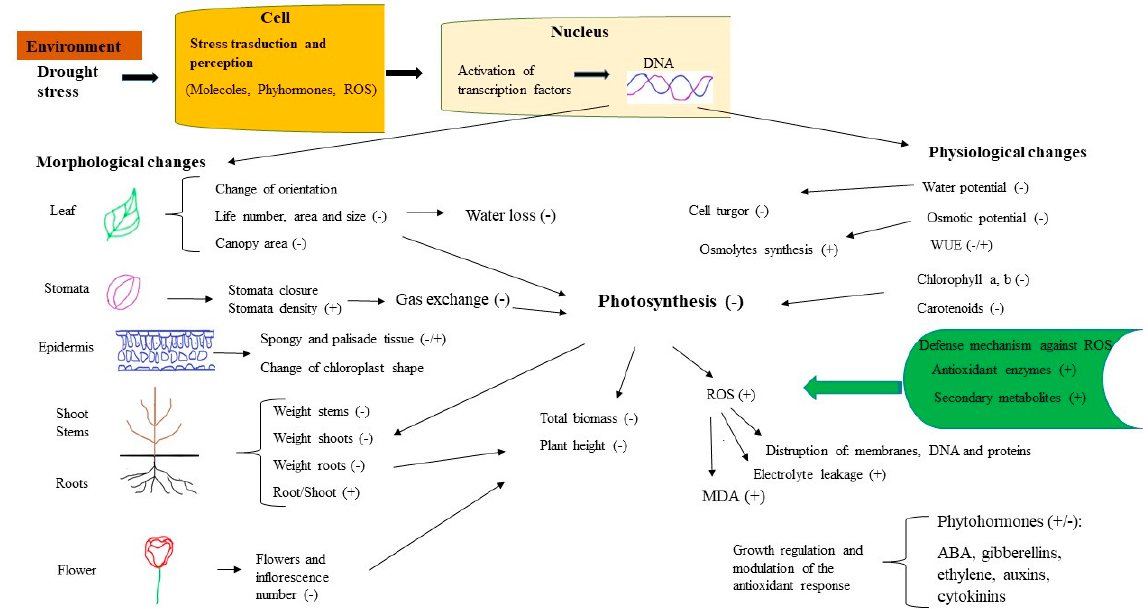
Figure 1. Water stress-induced morphological and physiological changes. ( − ) reduction due to water stress; (+) increase due to water stress. abscisic acid (ABA); malondialdehyde (MDA); reactive oxygen species (ROS); water use efficiency (WUE).